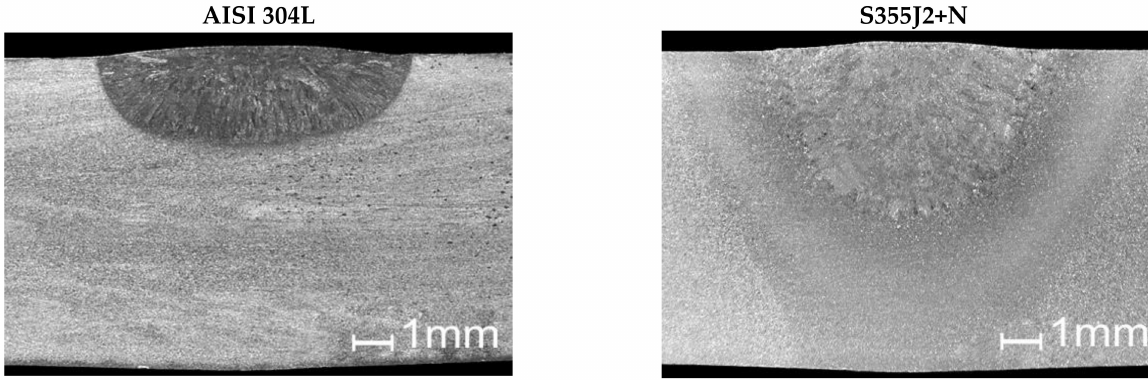
Figure 12. Macrostructure of the welds made on steels AISI 304L and S355J2+N using